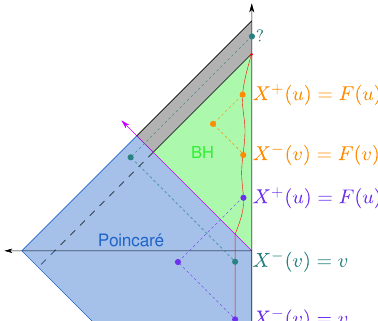
Figure 6 . The radar definition of how the boundary observer would associate coordinates to a bulk point [50]. The bulk point prior to the pulse but in the exterior corresponds to ( F ( u ) , v ) and for one after the pulse we get ( F ( u ) , F ( v )) . However, such a notion cannot be used for a bulk point in the interior — lying behind X + ( u ) = F ∞